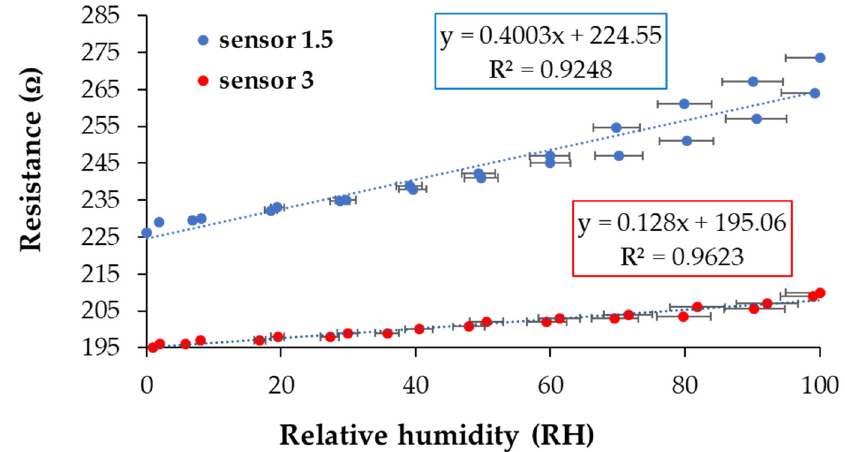
Figure 7. The response of ( a ) Sensor “1.5”, and ( b ) Sensor “3”, (“R curve”-blue) as a function of time for two measurement cycles when relative humidity was increased in ten steps from 0% RH to 100% RH; “RH curve-red” shows the similar characteristic measured for a commercial, capacitive sensor.